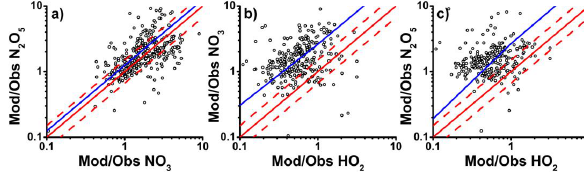
Figure 5: Relationships between modelled to observed ratios for (a) NO 3 and N 2 O 5 , (b) HO 2 * and NO 3 , and (c) HO 2 * and N 2 O 5 for summer and winter data combined. In each plot, the solid red line indicates the 1:1 line, with 50 % limits given by the broken red lines. The best fit lines are given in blue, and are described by (a) y = (1.3 ± 0.2) x – (0.4 ± 0.3), r 2 = 0.2, (b) y = (2.6 ± 0.5) x + (0.3 ± 0.1), r 2 = 0.1, (c) y = (2.8 ± 0.7) x – (0.1 ± 0.5), r 2 = 0.02.